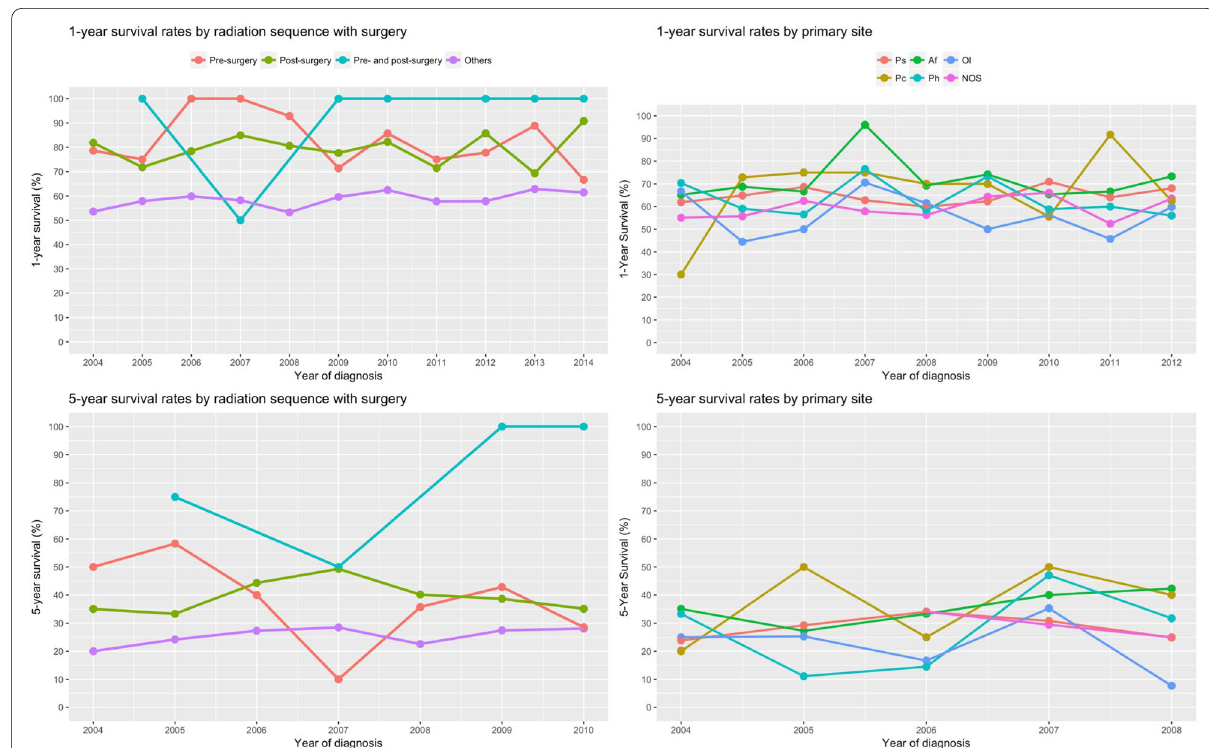
Fig. 1 One- and 5-year survival rates by treatment modality and primary site. Note: C12.9, pyriform sinus; C13.0, post-cricoid region; C13.1, aryepiglottic fold; C13.2, posterior wall of the hypopharynx; C13.8, overlapping lesion; C13.9, not otherwise